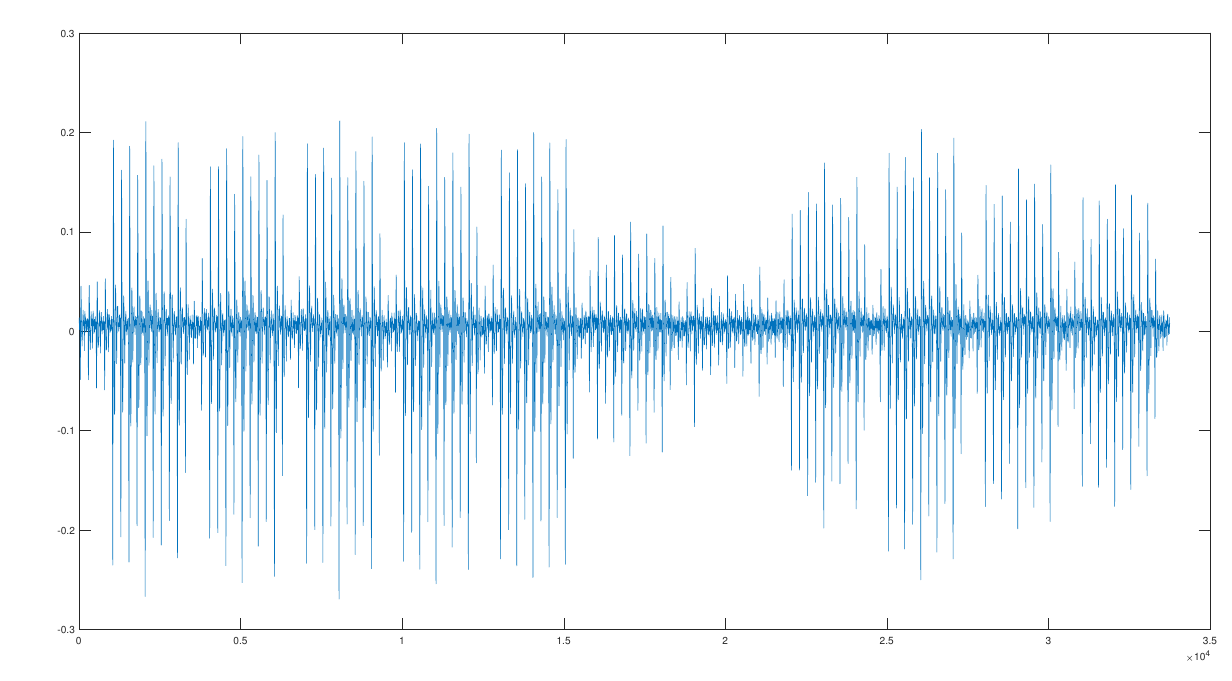
Figure 4. Sample of Unprotected implementation representing bit 1.